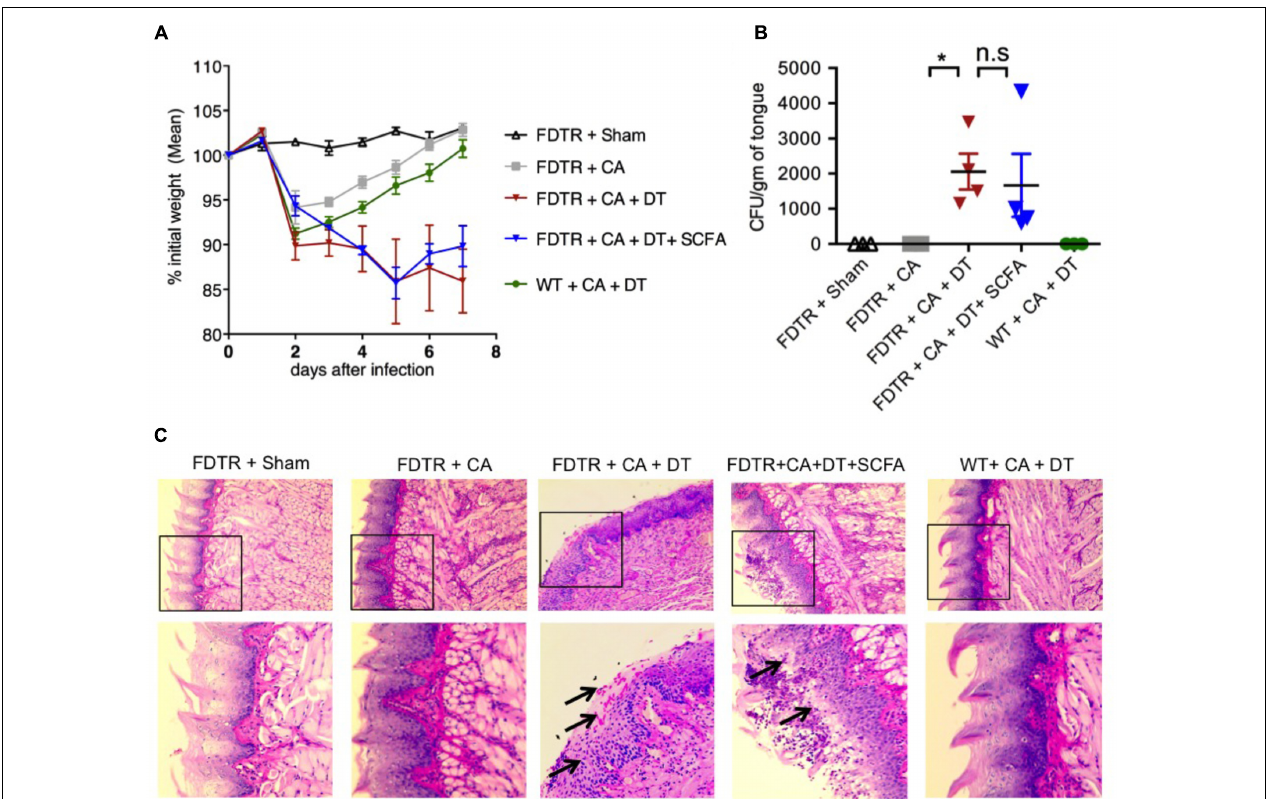
FIGURE 5 | T regs protect CA infected mice by reducing fungal burden and immunopathology. SCFA have little or no impact in fungal burden in T reg depleted FDTR mice. FDTR and WT mice were pre-injected with DT on days − 6, − 3, − 1, 0, 3, and 6 of infection ( n = 4/group). Some mice received SCFA as in the above regimen ( n = 4/group). (A) The percent weight change in mice with respect to d0 of infection. (B,C) On day 7 after infection, mice were re-infected with CA. Tongues were harvested on day 3 after re-infection. CFU/gm of tongue tissue (B) and tongue PAS staining (shown in 200 × magnification) (C) , assessing the fungal burden. Bottom panel in (C) shows magnified images of the region marked in the respective upper panels. Mean values ± SEM are plotted. P -values ( ∗ P < 0.05; n.s, non-significant) were measured using Mann–Whitney tests. These data represent three independent experiments showing similar